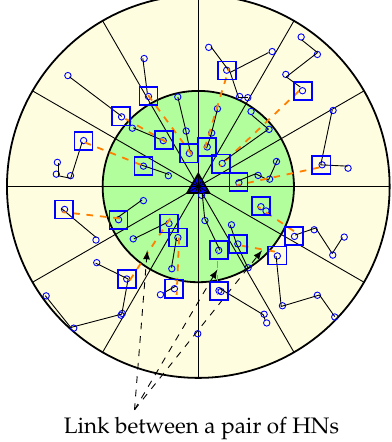
Figure 9. Data Communication Phase.